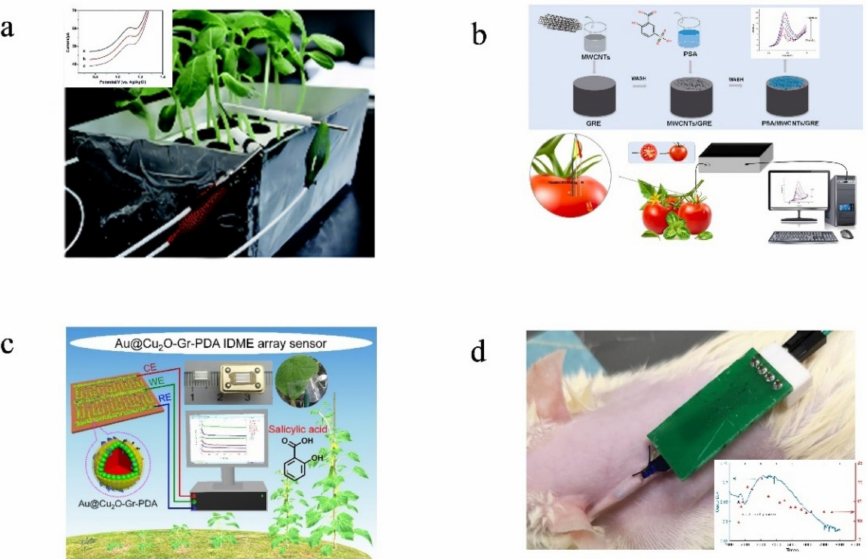
Figure 6. ( a ). Detection of salicylic acid in sunflower seedling stems by needle electrode [189]. ( b ) Detection of L-tryptophan in tomato by needle electrode. “Reprinted/adapted with